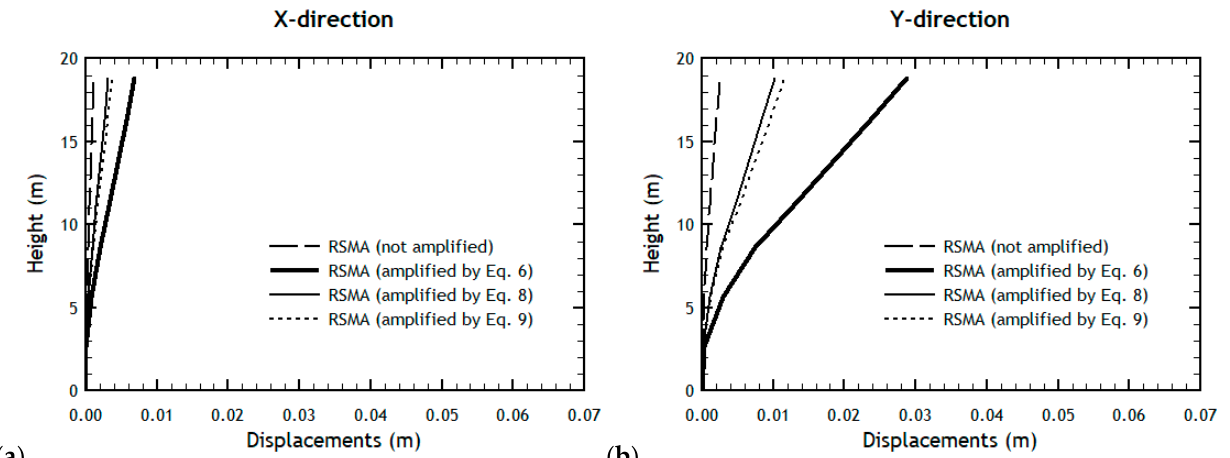
Figure 10. Maximum displacements obtained from the MRSA, with and without amplification factors in the X ( a ) and Y ( b ) directions.